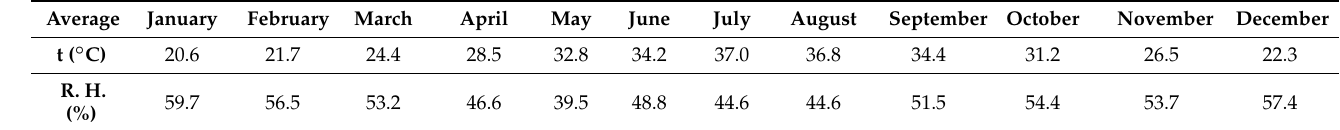
Table 1. Dubai climate, expressed in monthly